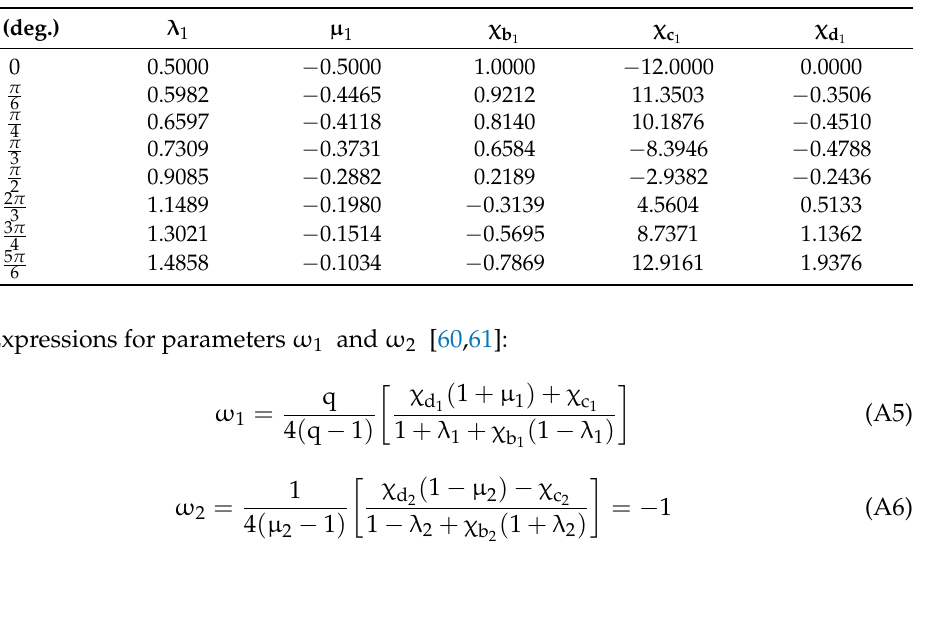
Table A2. Eigenvalues for different notch opening angles in mode II loading